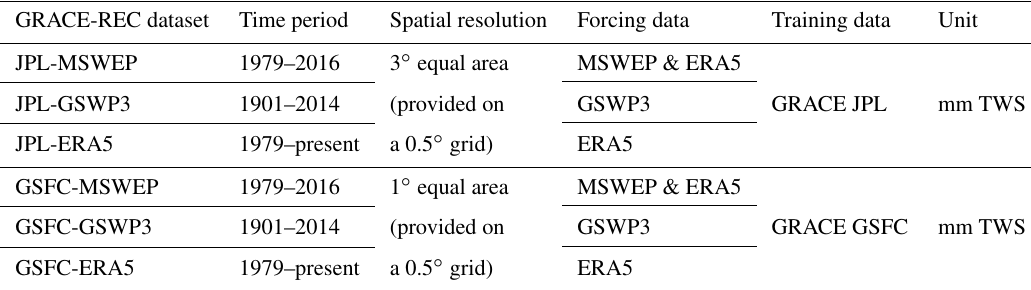
Table 3. List of the six GRACE-REC datasets available at monthly and daily scales. GRACE-REC